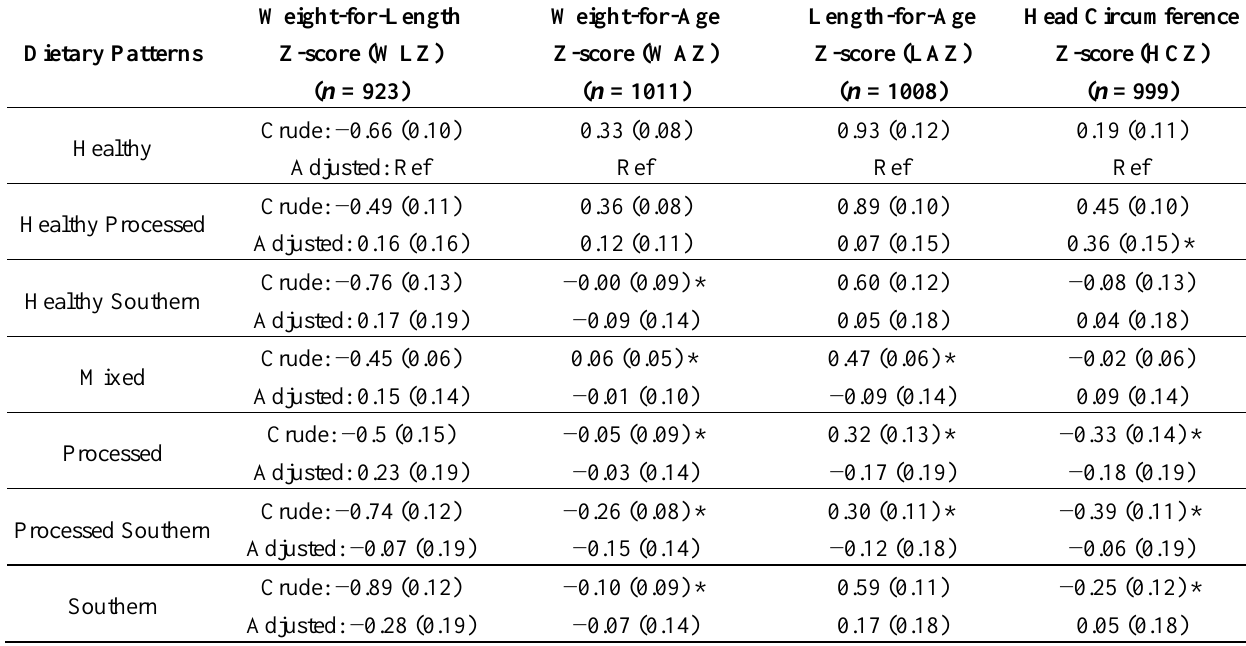
Table 3. Crude least square means (standard errors) and adjusted βeta estimates (standard errors) from generalized linear models of dietary patterns of mothers and newborn birth outcomes in